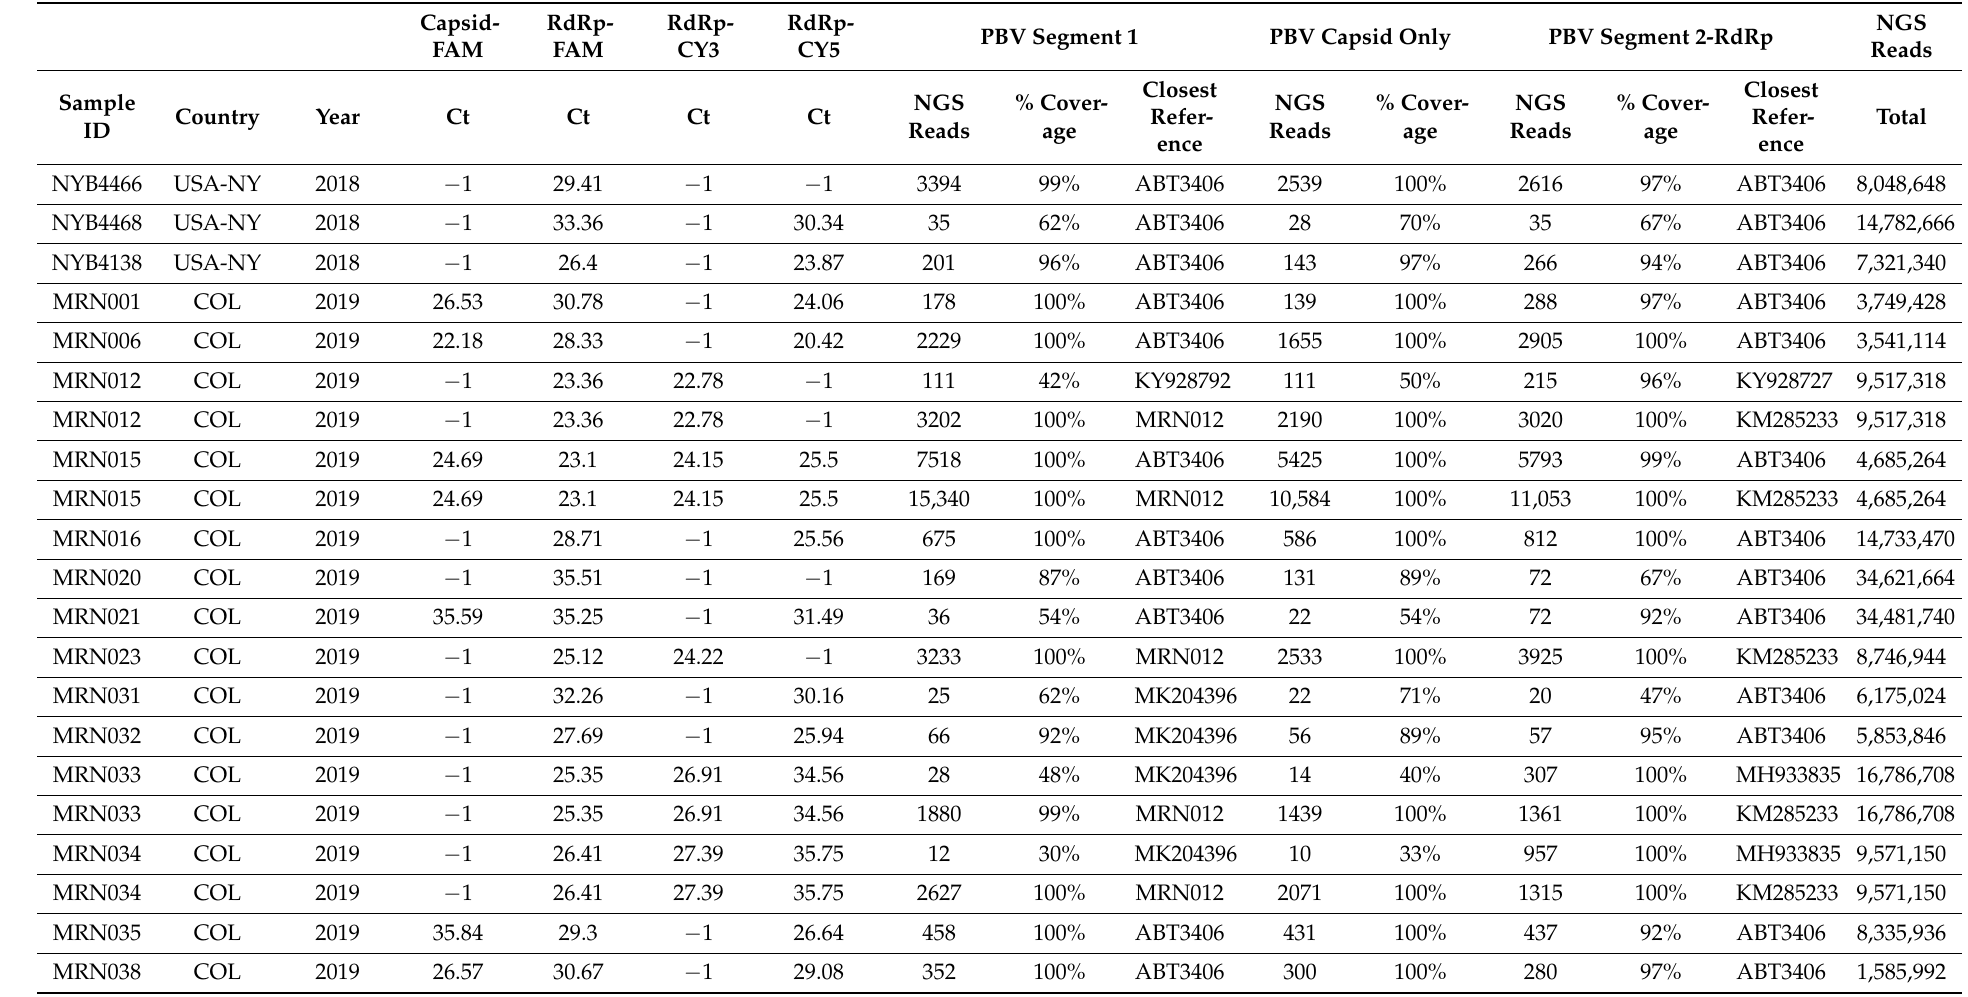
Table 1. Results of secondary screen for PBV positives: qPCR and NGS